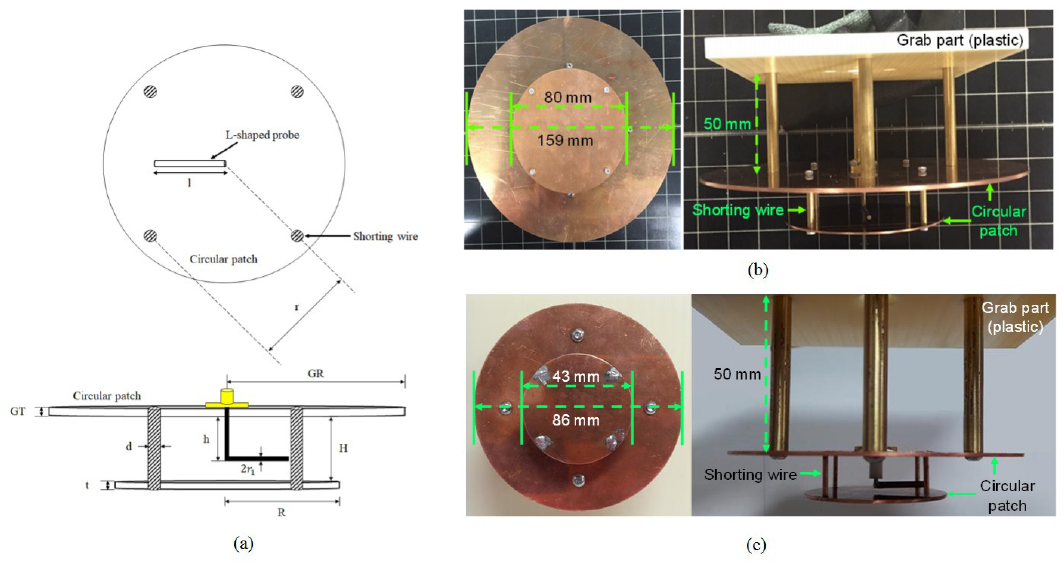
Figure 4. Design of proposed E-field probe (L-fed circular patch antenna): ( a ) Geometry and design parameters; ( b ) Photograph of the fabricated E-field probe for 1.2–1.4 GHz range (1st E-probe); and ( c ) Photograph of the fabricated E-field probe for 2.7–3.1 GHz range (2nd E-probe). Table 2. Designed parameters of the two fabricated E-field probes of Figure 4b,c (all units in mm). Design